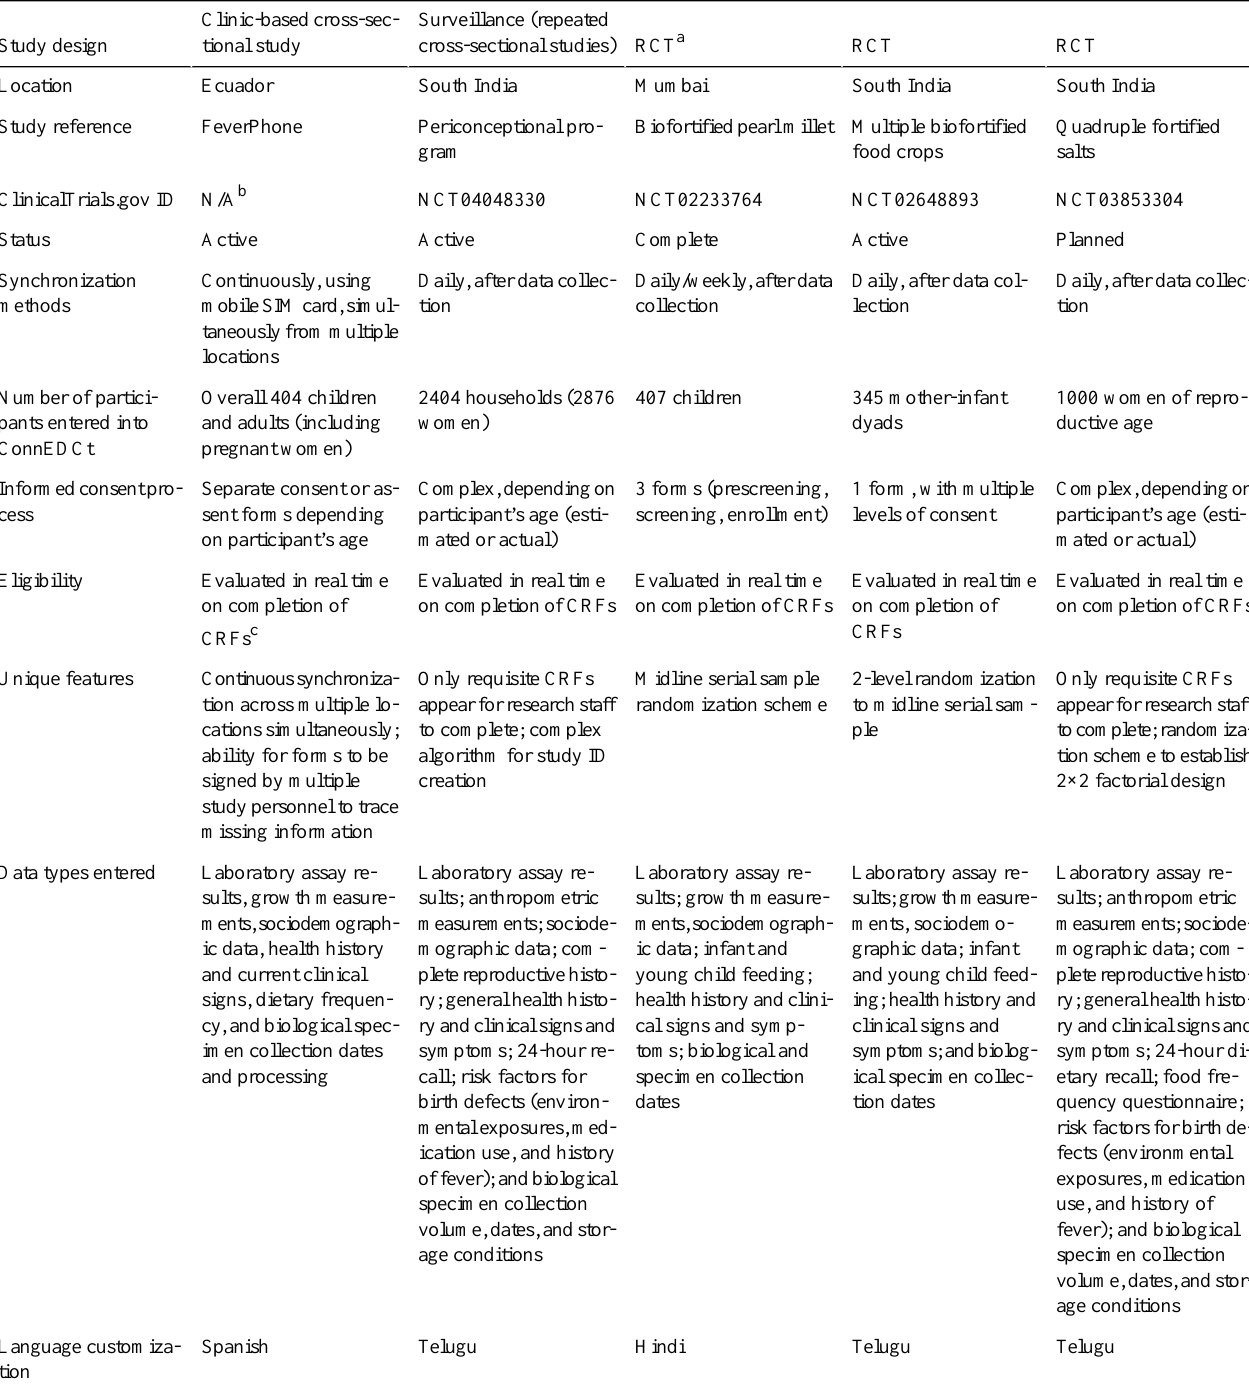
Table 2. ConnEDCt usage in case studies: clinic-based cross-sectional studies, surveillance studies, and randomized controlled